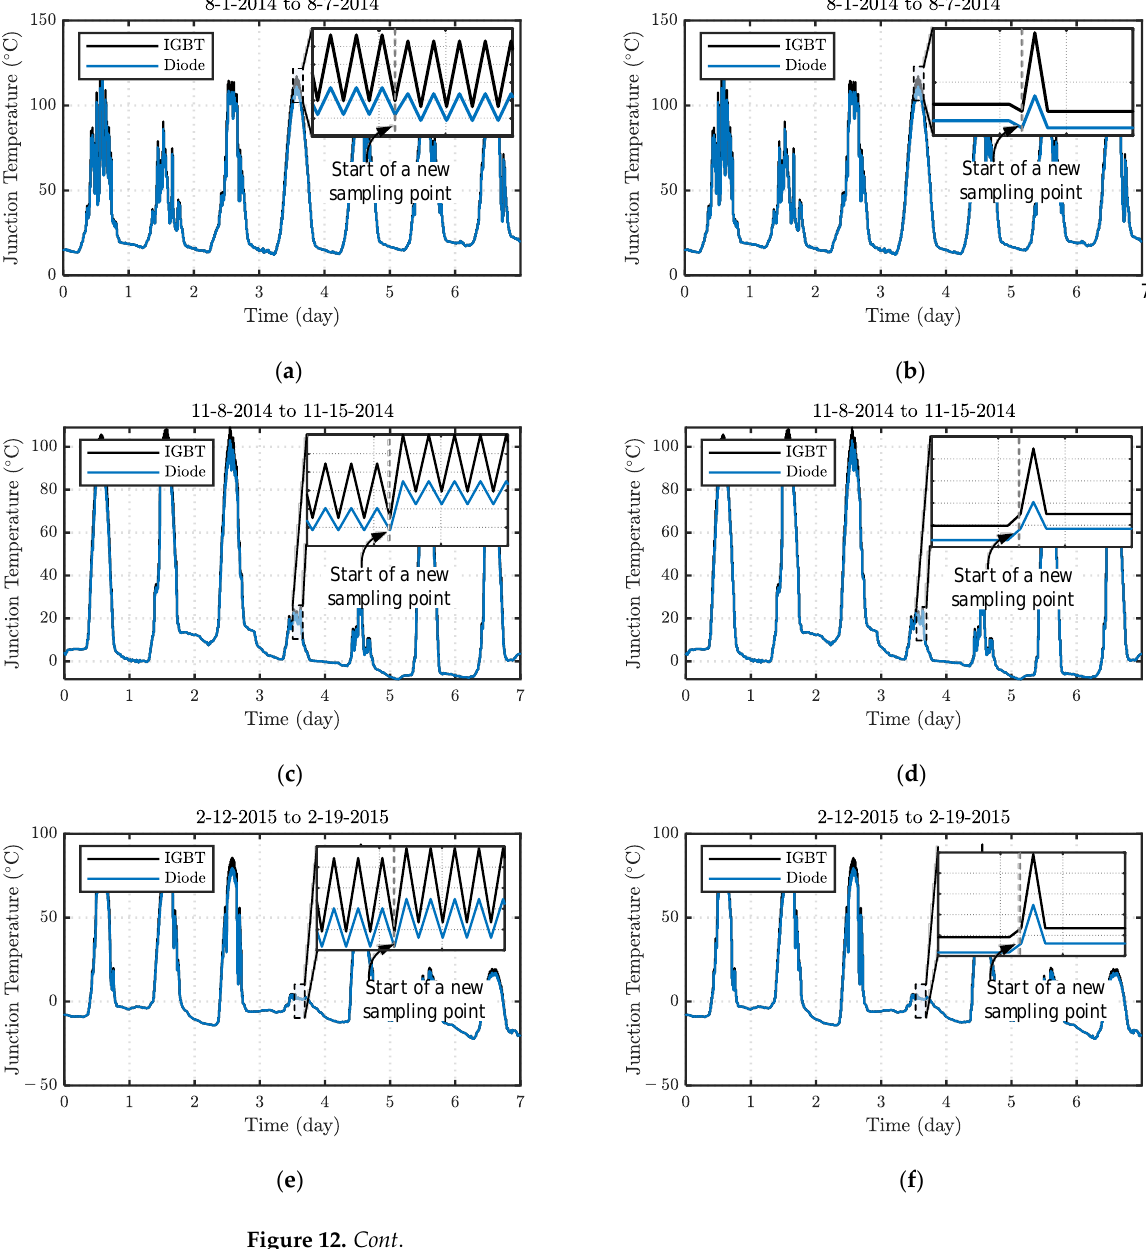
( h ) Figure 12. IGBT and diode junction temperature profile for a PV inverter with 7 days of insolation data. ( a ) Sample complete peak – valley profile for 4 August 2014; ( b ) sample reduced peak – valley profile for 4 August 2014; ( c ) sample complete peak – valley profile for 11 November 2014; ( d ) sample reduced peak – valley profile for 11 November 2014; ( e ) sample complete peak – valley profile for 15 February 2015; ( f ) sample reduced peak – valley profile for 15 February 2015; ( g ) sample complete peak – valley profile for 11 May 2015; and ( h ) sample reduced peak – valley profile for 11 May 2015. 5.2. Rainflow Counting The rainflow-counting algorithm is tested with (a) 7-day complete peak – valley pro- file, (b) 7-day reduced peak – valley profile, (c) 7-day averaged peak – valley profile, (d) 2- year reduced peak – valley profile, and (e) 2-year averaged peak – valley profile. The rain- flow-counting results are displayed in Figure 13. Figure 13a – c show the 7-day rainflow counting results using the complete peak – valley profile, reduced peak – valley profile, and averaged peak – valley profile, respectively. The rainflow-counting results shown in Figure